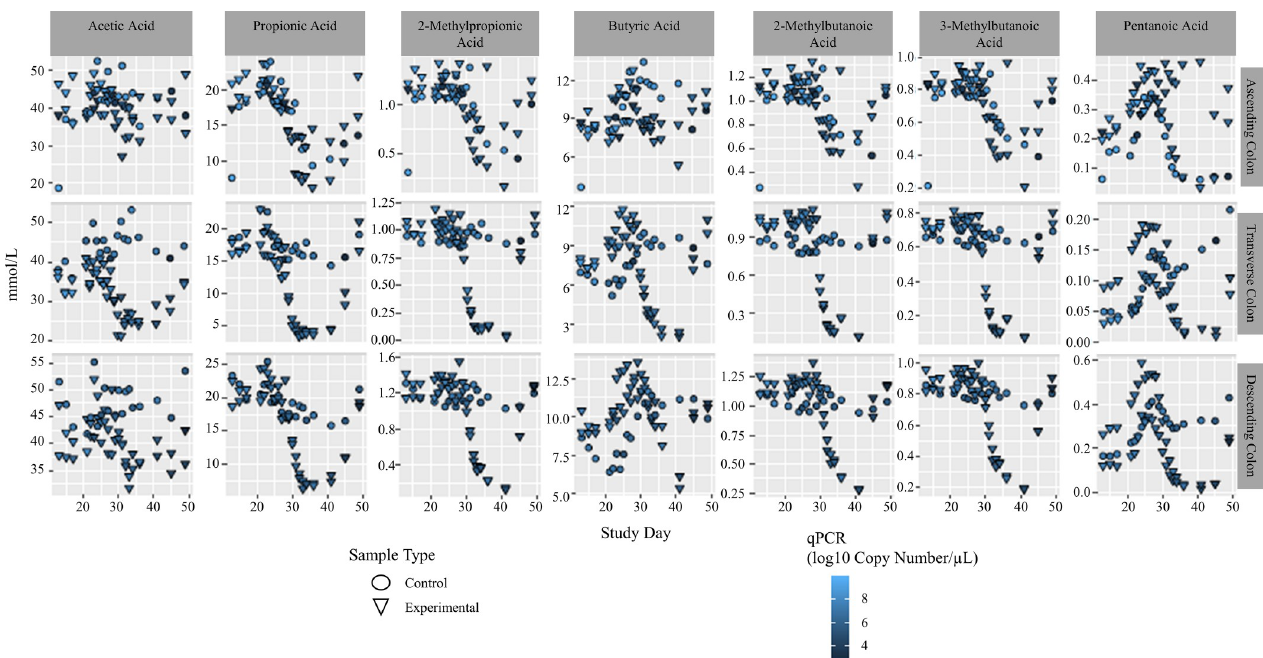
Fig 6. Short chain fatty acid data combined with copy number (qPCR). Top plots show the ascending colon, middle plots are the transverse colon, bottom plots are the descending colon. Copy number data is shown via a blue color gradient.